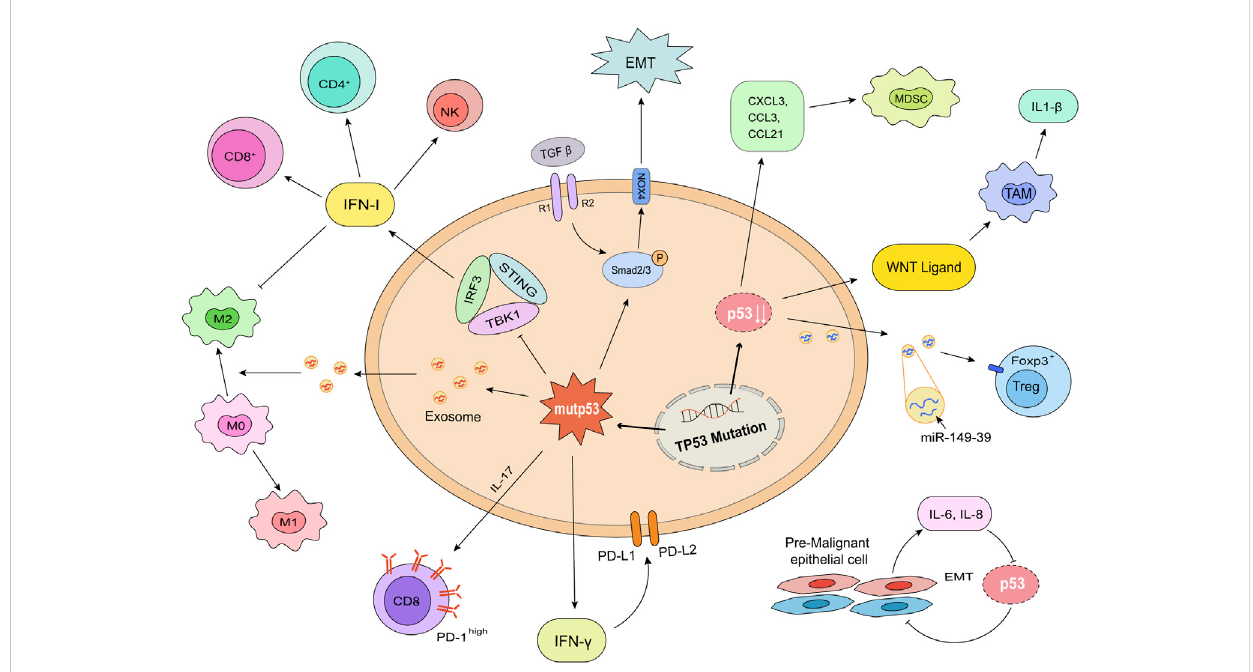
p53 mutation and deletion shape an immunosuppressive environment. The consequences of mutation (left) or deletion (right) of p53 in tumor cells are shown. Mutp53 decreased the release of IFN I, consequently decreased the in fi ltration of CD4 + T cells, CD8 + T cells, and NK cells. Mutp53 promoted theformationofexhaustedCD8 + TcellsthroughIL-17signaling.TheincreasedIFN γ playedaroleintheexpressionofimmunosuppressiveligands,PD-L1 and PD-L2. Mutant p53 has a synergistic effect with TGF- β to promote EMT. p53 deletion upregulated the releasing of WNT ligands, CXCL1, CCL3, CCL21, and miR-149 – 39 to enhance the differentiation of TAMs and Tregs. Pre-malignant epithelial cells would release IL-6 and IL-8 to promote EMT. This process promoted tumor formation and